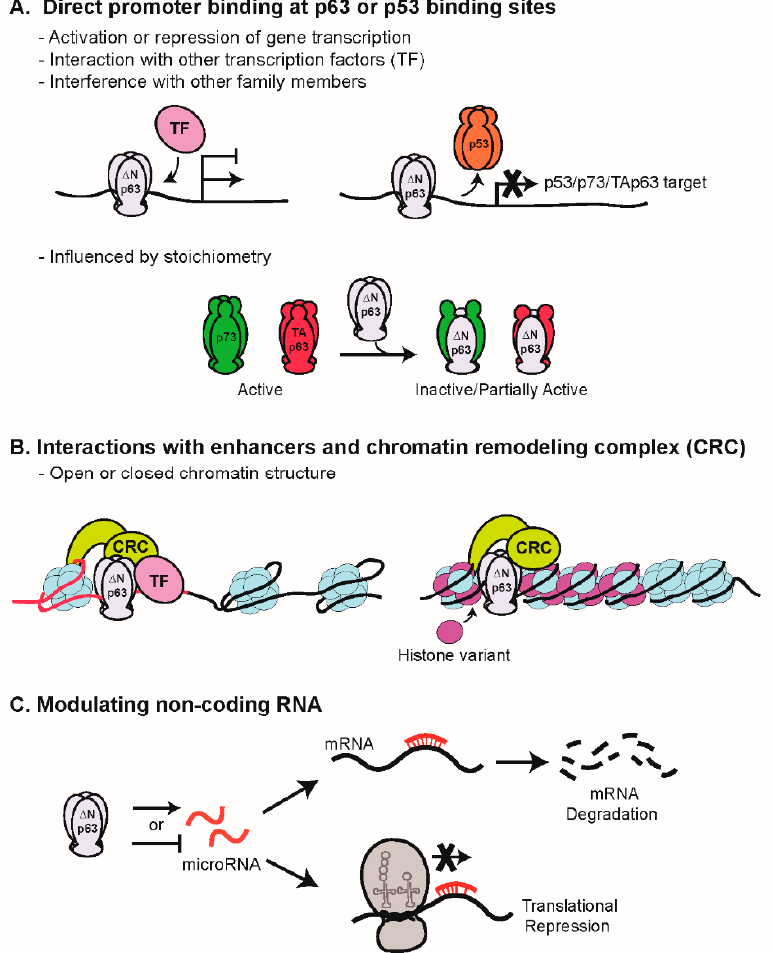
Figure 2. p63 mediates gene expression via multiple mechanisms. ( A ) Direct promoter binding: ∆ Np63 α activates or represses transcription by binding to promoters of its target genes and associating with other transcription factors to enhance or suppress transcriptional activity. The stoichiometric balance of the p63 and p73 isoforms can modulate the activity; these interactions can lead to di ff erent transcriptional programs and altered biological outcomes. ( B ) Interactions with enhancers and chromatin remodeling complex: At sites of high histone acetylation (e.g.; H3K27), p63 interaction with the chromatin remodeling complex (CRC) maintains an open chromatin landscape controlling access to epidermal enhancers and super enhancers to drive gene activation in conjunction with other transcription factors. In this way, p63 directs tissue-specific gene regulation guiding epidermal di ff erentiation. ( C ) Activation or repression of non-coding RNAs: Long non-coding RNA and microRNA are targets of ∆ Np63 regulation, thereby indirectly modulating gene expression. Examples of ∆ Np63 α activating or repressing transcription of miRNAs are shown.